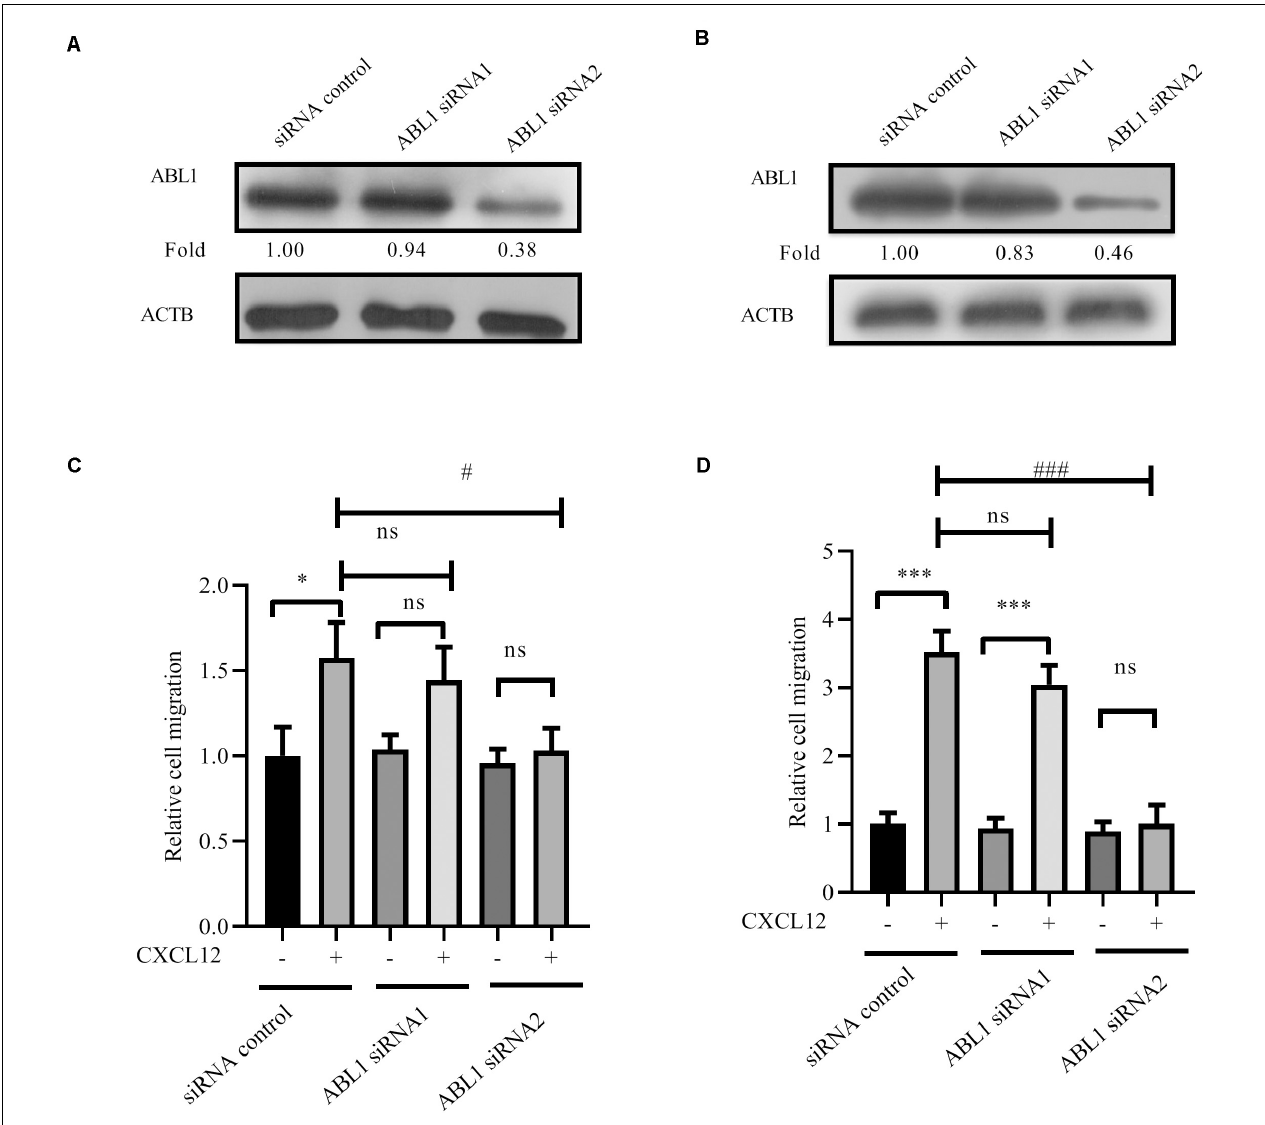
FIGURE 9 | Knockdown expression of ABL1 by siRNAs inhibited CXCR4-mediated T-ALL migration toward CXCL12. (A,B) siRNAs were transfected into JURKAT or CCRF-CEM cells using the methods described in the materials and methods section; 48 h after transfection, cell lysates were prepared for Western blot assay to detect the interference efficiency of siRNAs on ABL1. Western blot bands were analyzed using Image Pro Plus 6.0, and fold changes of ABL1 were normalized according the loading control ACTB. (C,D) Transfected cells were used in the transwell assay. Each experiment was repeated at least three times. * p < 0.05, *** p < 0.001, comparing with the negative control (CXCL12 − ) group. # p < 0.05, ### p < 0.001, comparing with the positive control (CXCL12+)